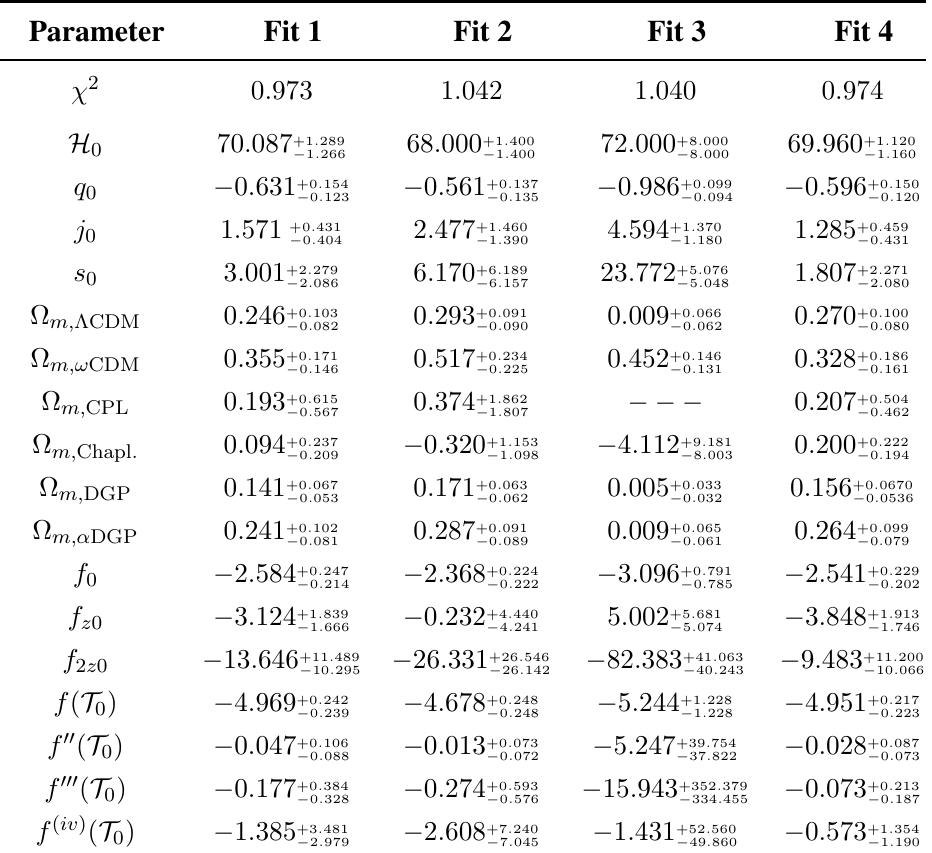
Table 1. Table of cosmographic results. We reported the values of the cosmographic series (CS) by considering four different cosmological fits through the use of supernovae Ia (SNeIa), baryonic acoustic oscillation (BAO) and cosmic microwave background (CMB) measurements. In so doing, we minimized the chi-squared given by Equation (125), and we performed standard Bayesian analyses. In particular, the first fit leaves the coefficients free to vary; the second one assumes H 0 fixed to the PLANCK value. The third fit uses H 0 fixed in terms of the Hubble Space Telescope (HST) measurement, whereas the last fit fixes the value of the Hubble rate today, through the fit of a first order d L within the interval z < 0 . 36 by using SNeIa measurements only. The values of Ω m , f 0 , f z 0 , f f ( T ) , f (cid:48)(cid:48) ( T ) , f (cid:48)(cid:48)(cid:48) ( T ) and f ( iv ) ( T ) have been obtained by using standard error propagations. 2 z 0 , 0 0 0 0 The value of f (cid:48)(cid:48)(cid:48) ( T 0 ) for fit 3 is in powers of 10 3 , while the value of f ( iv ) ( T 0 ) is in powers of 10 8 . Moreover, fit 3 cannot constrain the Chevallier–Polarsky–Linder (CPL) model, showing that this model is disadvantageous for high values of s 0